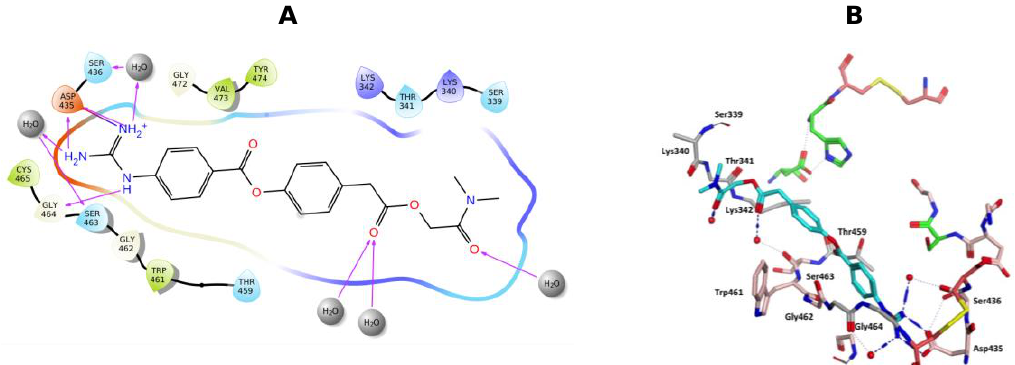
Figure 10. ( A ) 2D Ligand interactions and ( B ) 3D visualization of camostat (cyan).